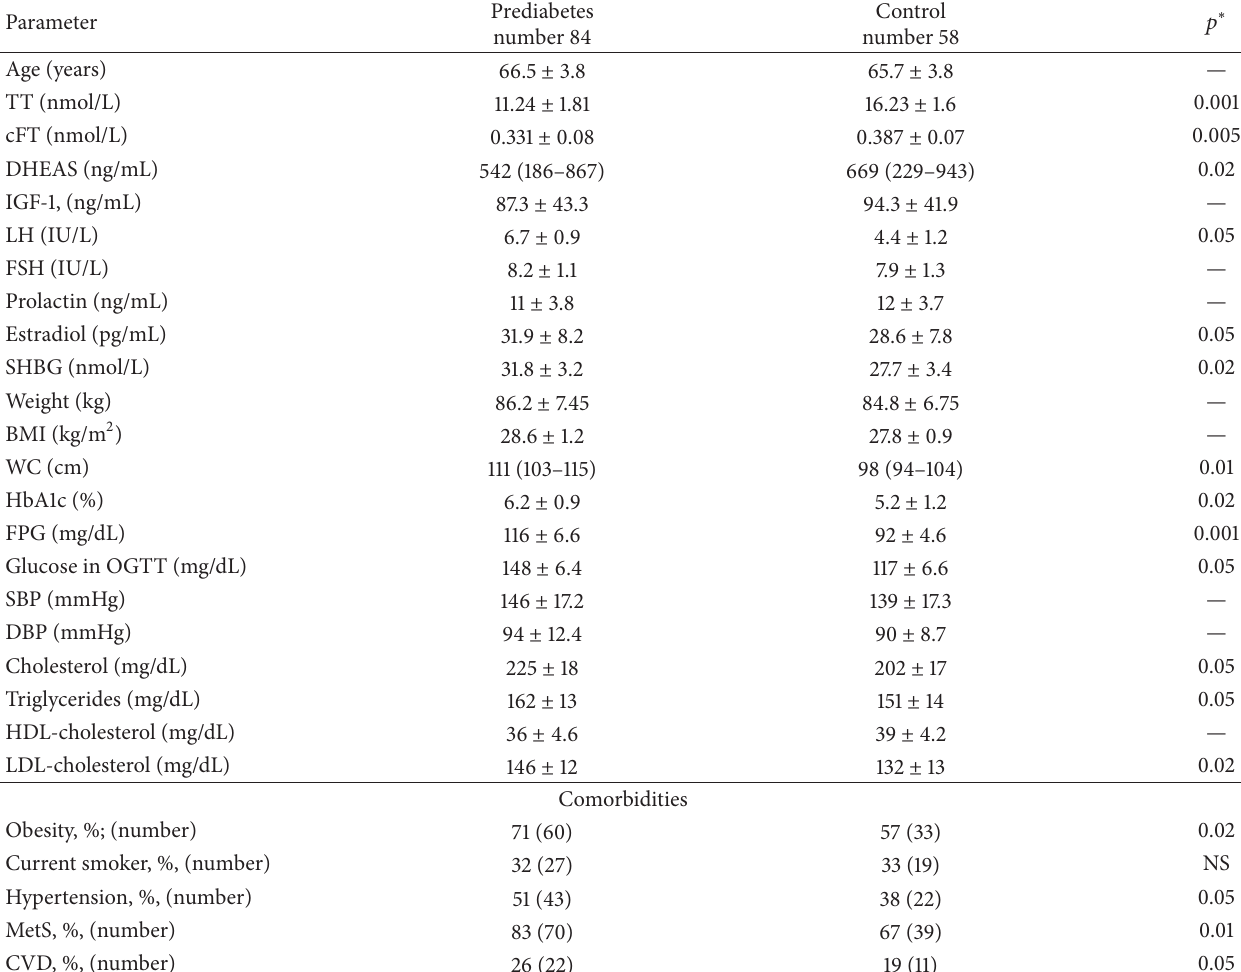
Table 1: Characteristics of men with PD and control